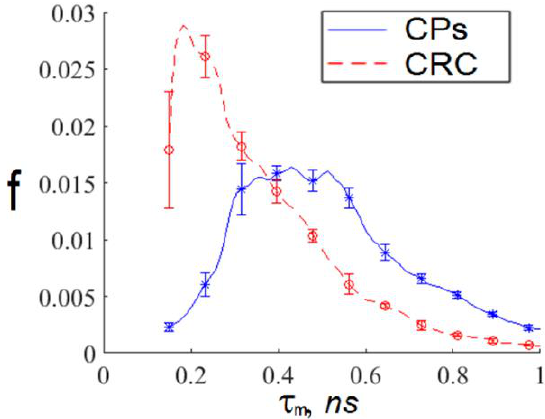
Figure 8. The average TPAF lifetime t m distributions for of the exosome samples, normalized on an area under the curve, for the whole dataset processed by the cutting filter with a threshold of 800 photons per pixel and the circle masks described by Formulas (6) and (7) in a phasor plane. Notations on the legend: CPs—the exosome samples from the whole CRC patient group; CRC—the exosome samples from the whole CP patient group. The t m distribution mean values and standard deviations were calculated by t m value-averaging over images presented in Figure 7a,b. Table 1. Mean and standard deviations for the distributions shown in Figure 8.